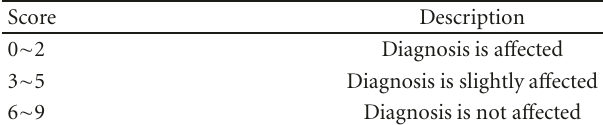
Table 7: The comparison results with existing